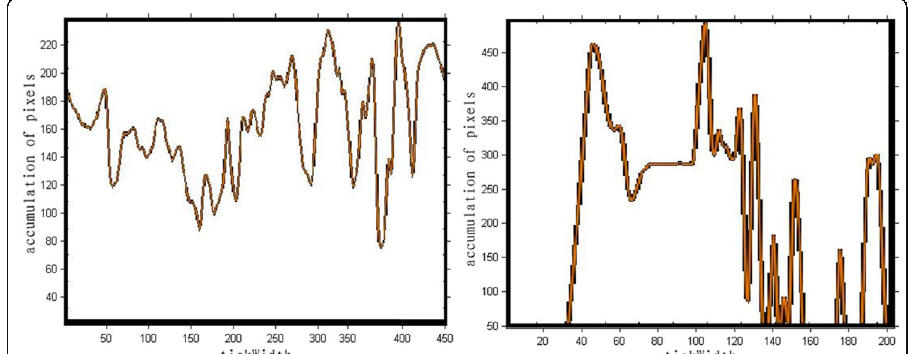
Fig. 7 Example of integration projection based on images in arc